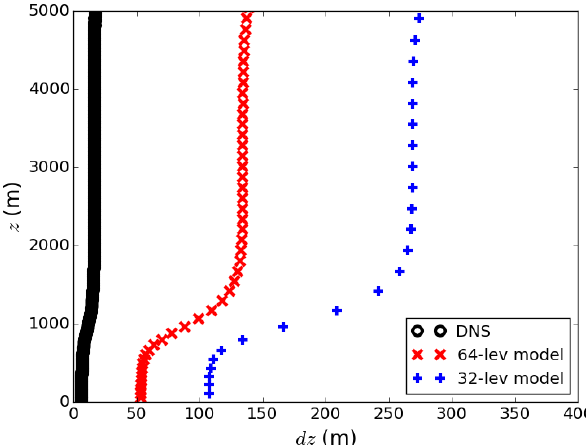
Figure 7. Plot of the vertical grid spacing (d z ) (in equivalent to vertical resolution) vs. height ( z ) in the DNS model (black), the 64lev coarse-grid models (red) and the 32lev coarse-grid models (blue) in the first